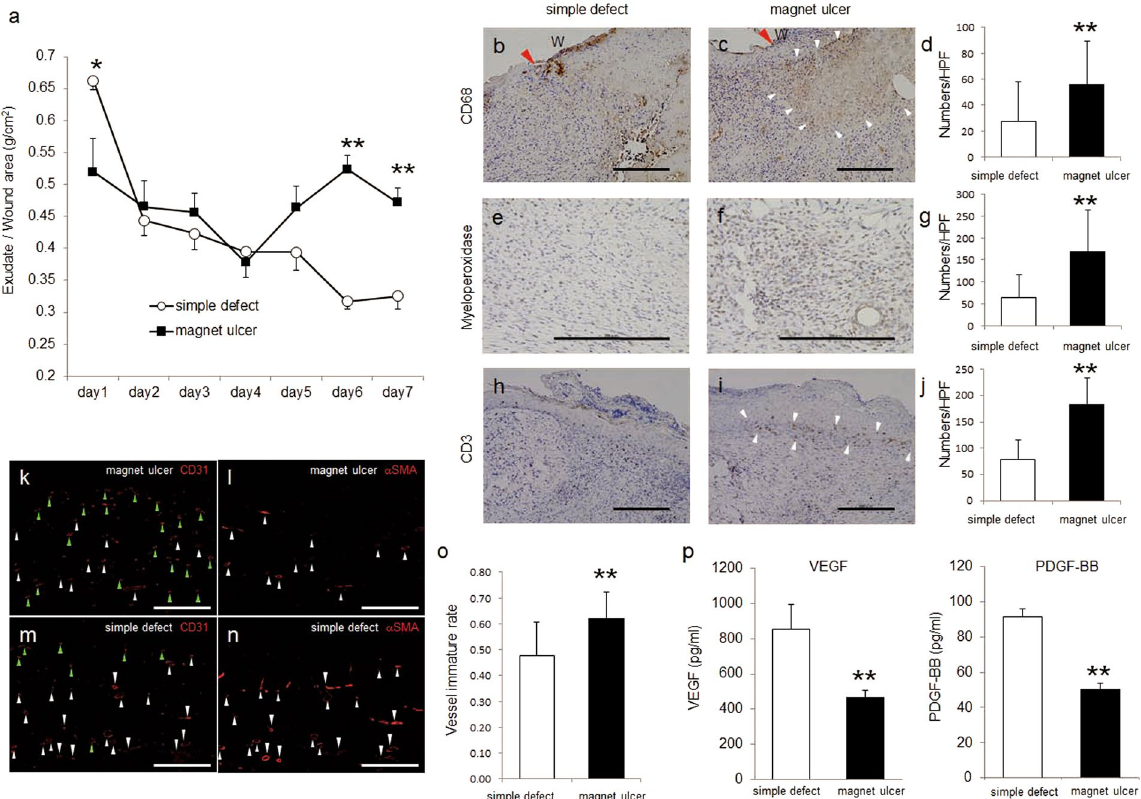
Figure 2. Inflammatory properties of the magnet-implanted ulcer model. ( a ) Exudate from wounds was analyzed daily by measuring the weights of dressings and correcting the ulcer areas 7 days after forming ulcers using each model. * P < 0.05 versus simple defect, ** P < 0.01 versus simple defect. ( b , c , e , f , h , and i ) Immunohistochemical analysis of macrophages (CD68), neutrophils (myeloperoxidase), and T lymphocytes (CD3) on day 7 (scale bar = 200 µ m). In ( b ) and ( c ), red arrowheads indicate the wound edge. In ( c ), white arrowheads indicate the infiltration area macrophages. (W, wound) In ( i ), white arrowheads indicate the infiltration area of T lymphocytes at the bottom of the epidermis. ( d , g , and j ) Eight of high-power fields in three serial sections were counted and averaged for macrophages, neutrophils, and T lymphocytes respectively. ( k – n ) Immunohistochemical analysis of CD31 and α -SMA in the magnet-implanted ulcer model and the simple skin defect. ( k , l , m and n) were the serial sections. The white arrowhead indicates CD31 + α -SMA + vessels and the green arrowhead indicates CD31 + α -SMA − vessels (scale bar = 200 µ m). ( o ) comparison of the CD31 +